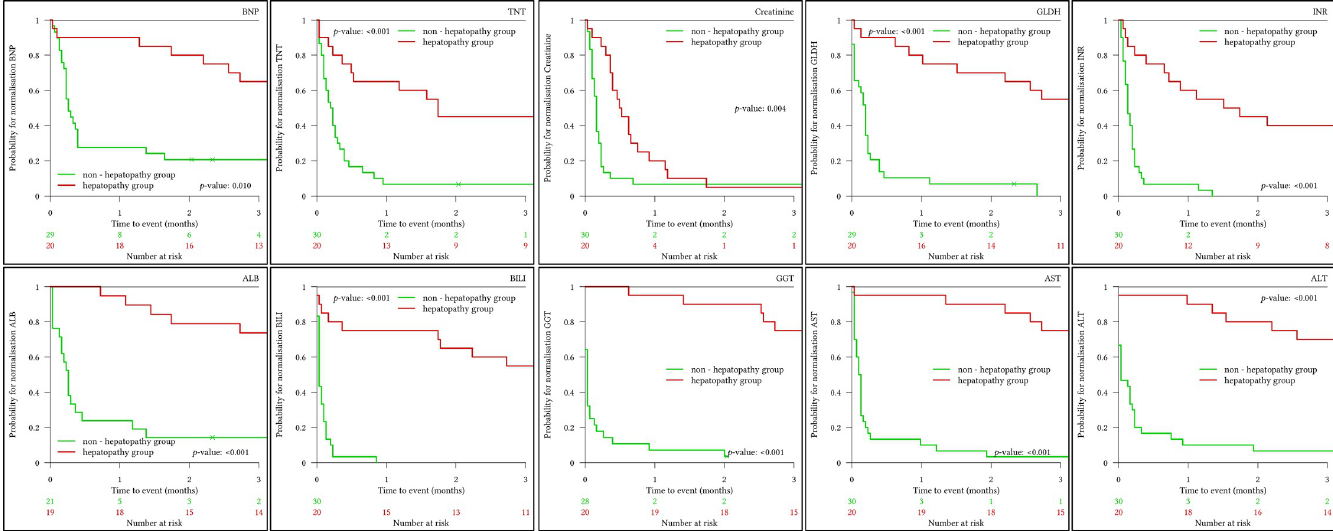
Fig 1. Laboratory trend normalization analysis. Kaplan Meier analysis to calculate the probability of value normalization for the following laboratory parameters: BNP–pro-brain natriuretic peptide, TNT–troponin T, creatinine, GLDH–glutamate dehydrogenase, INR–international normalized ratio for prothrombin time, ALB– albumin, BILI–bilirubin, GGT–gamma-glutamyltransferase, AST–aspartate transaminase and ALT–alanine transaminase. Time to event describes the time period for complete laboratory value normalization.